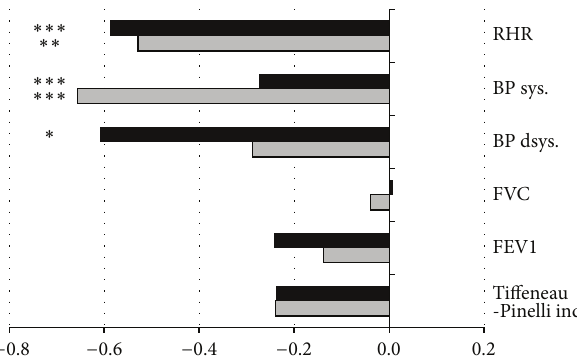
Figure 4: Rate of changes of cardiac and spirometric indices after Active Leisure Time Programme (black bars) and Prevent Falls in the Elderly Programme (grey bars), compared to baseline. Note: values are mean normalised outcomes. RHR: heart rate at rest; BP sys.: systolic blood pressure; BP dsys.: diastolic blood pressure; FVC: forced vital capacity; FEV1: forced expiratory volume in 1 second; FEV1/FVC: Tiffeneau-Pinelli index. Levels of statistical significance: ∗ 𝑃 < 0.05 , ∗∗ 𝑃 < 0.01 , and ∗∗∗ 𝑃 < 0.001 .